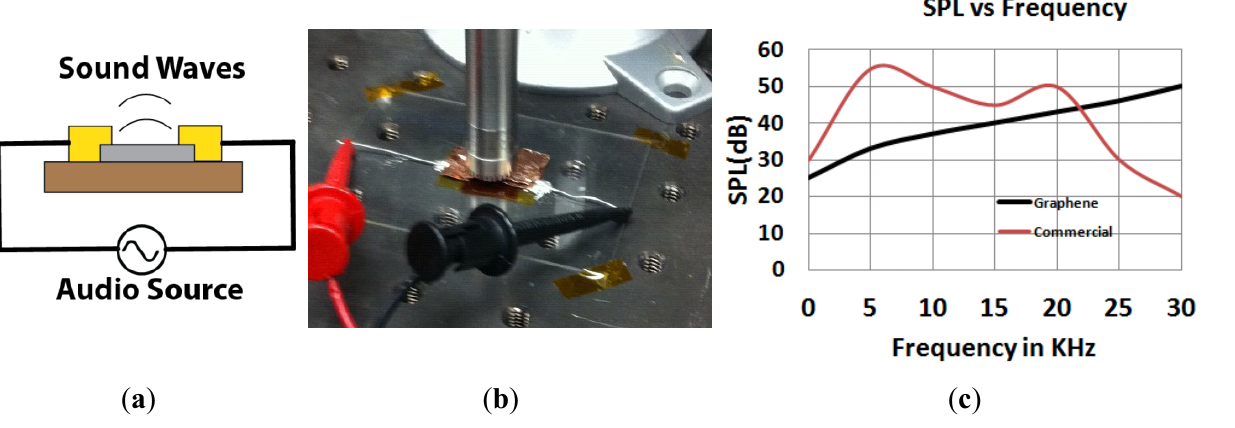
Figure 11. ( a ) Side view of graphene speaker (grey—monolayer graphene, yellow—gold contacts, brown—PI substrate); ( b ) Fabricated graphene speaker and microphone test setup; ( c ) SPL vs. frequency plot comparing flexible graphene speaker with a commercial